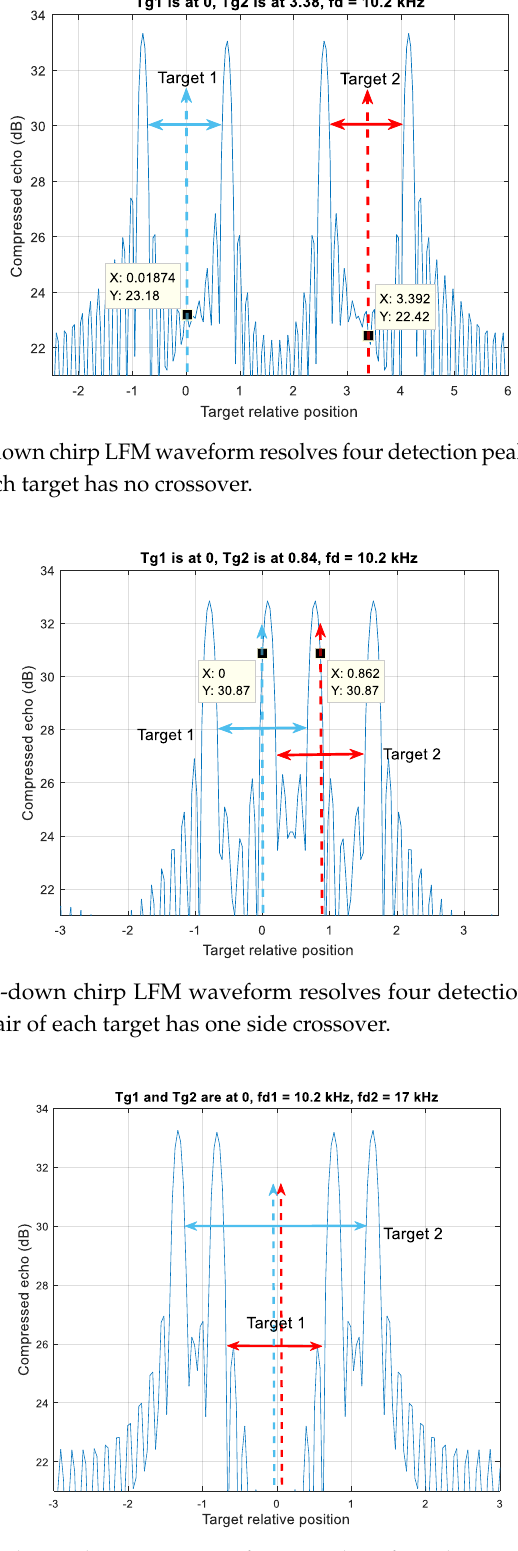
Figure 7. Case 3, an up-down chirp LFM waveform resolves four detection peaks by two moving targets. The detection pair of target 1 is enclosed by the pair of target 2.